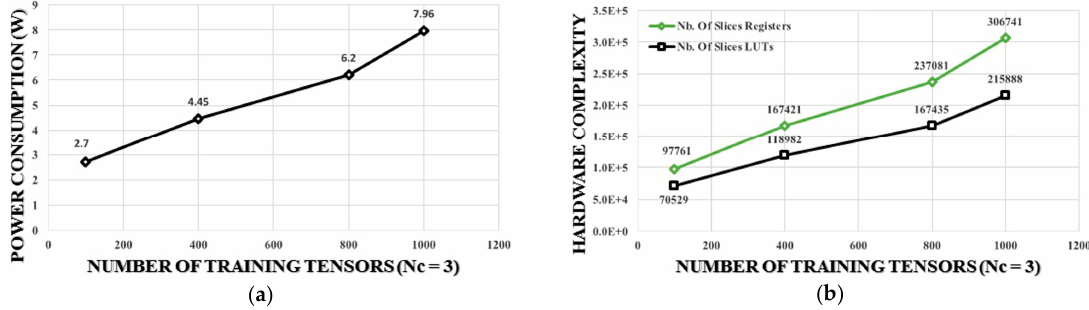
Figure 7. Training tensors versus ( a ) power consumption and ( b ) hardware complexity ( Nc = 3).